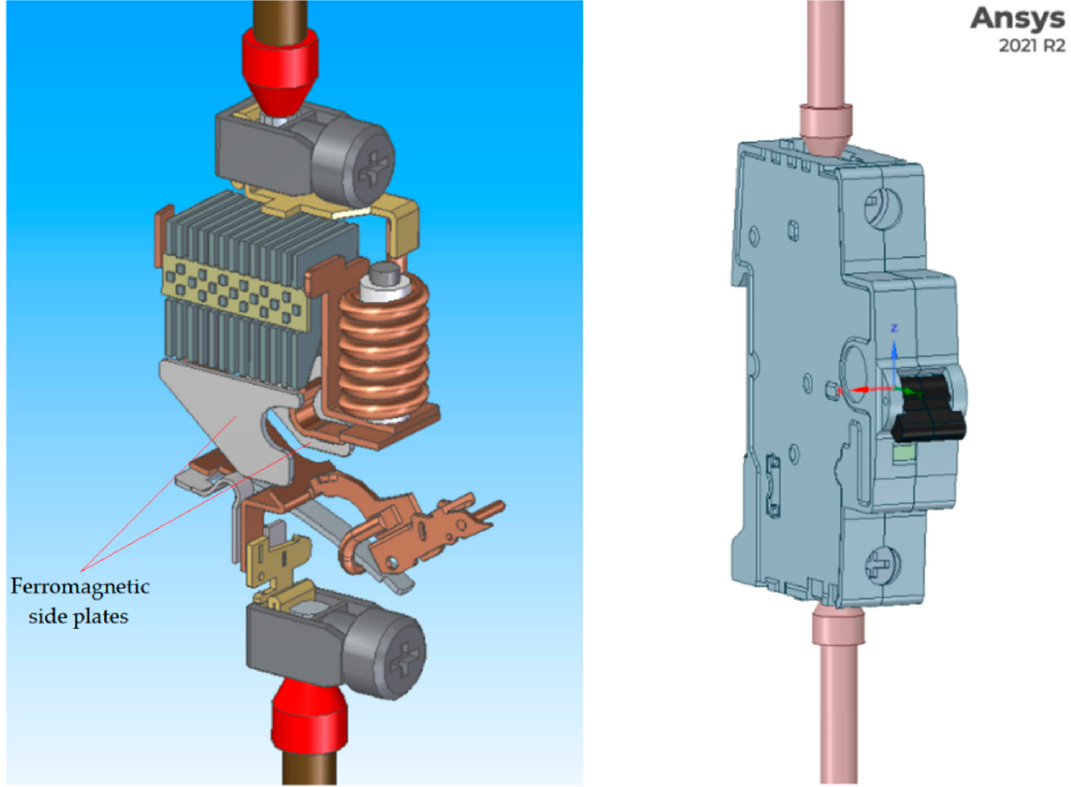
Figure 9. Precise 3D model of the circuit breaker prepared for numerical analysis conducted by the ANSYS software.